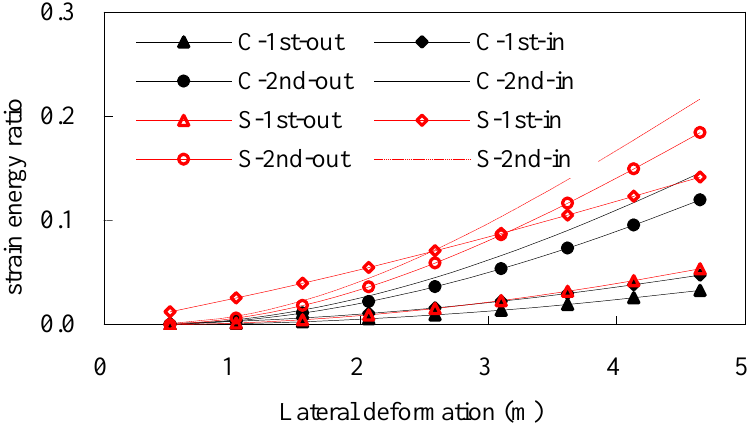
Figure 8. Strain energy ratios of steel and CFRP